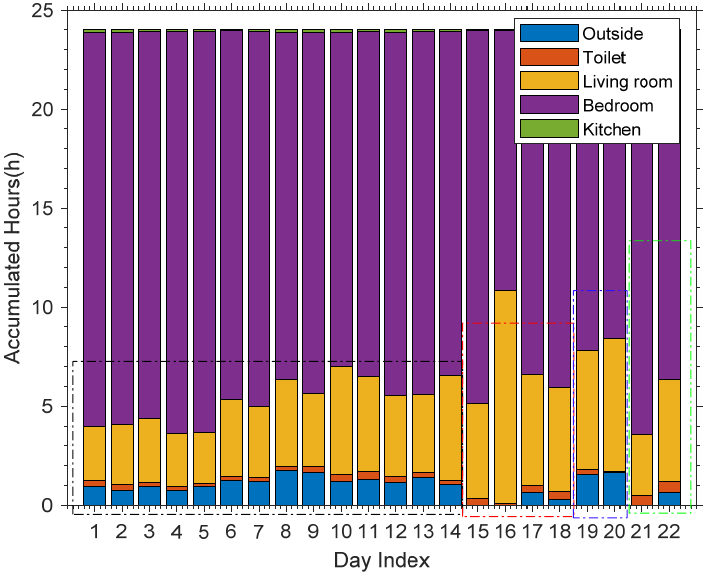
Figure 18. The area occupation rate of volunteer 1 during 24 h.